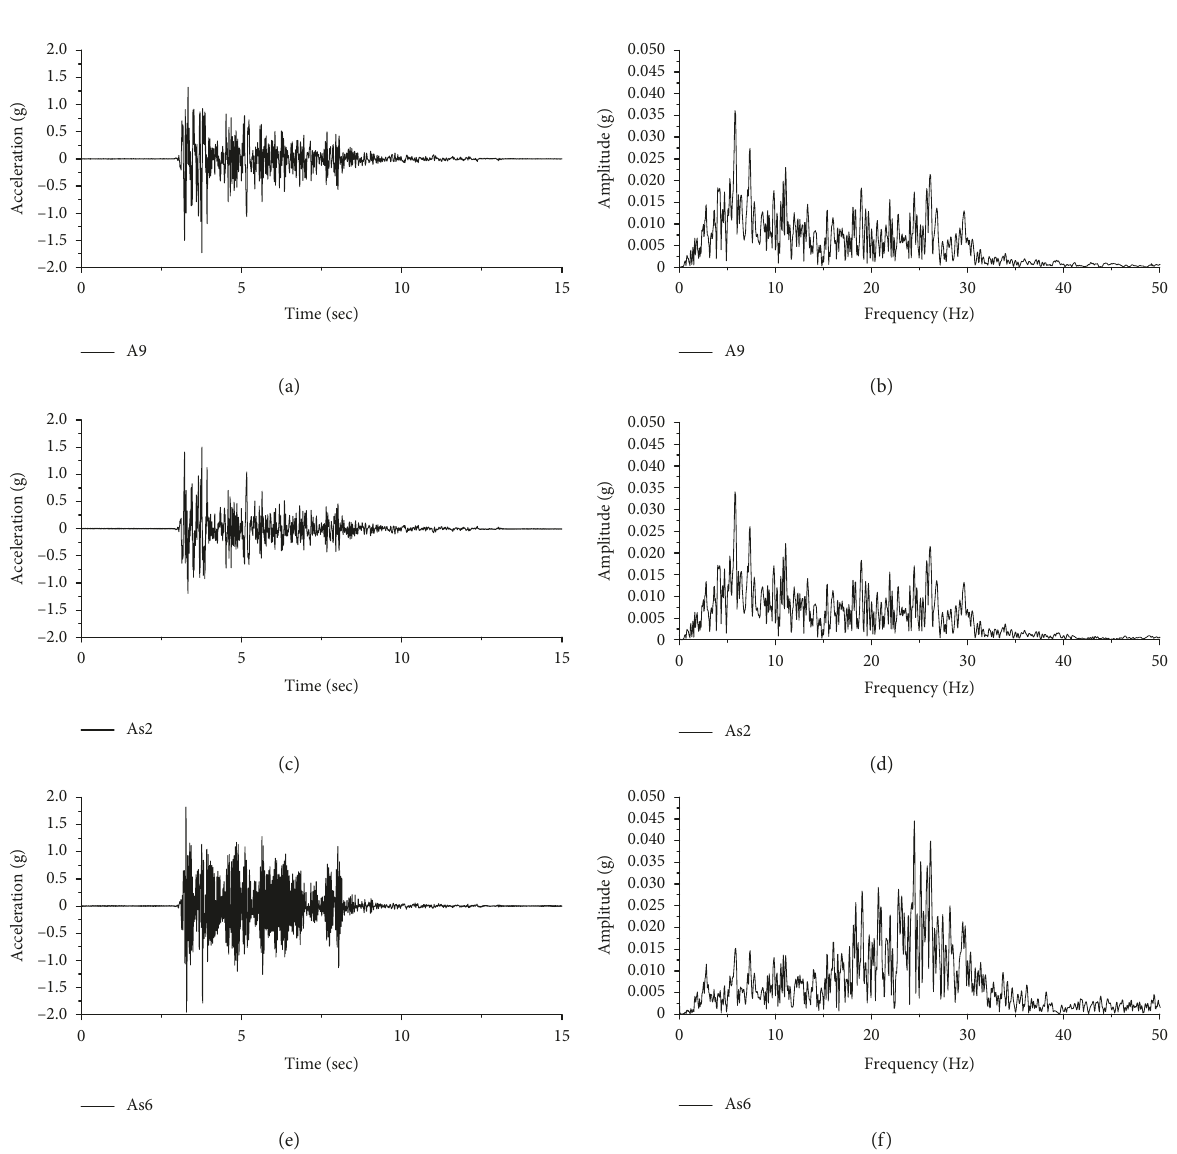
Figure 10: Dynamic responses of horizontal acceleration and Fourier spectra in the case of 0.75g. (a, b) A9 of model soil. (c, d) As2 on the model tunnel. (e, f) As6 on the model